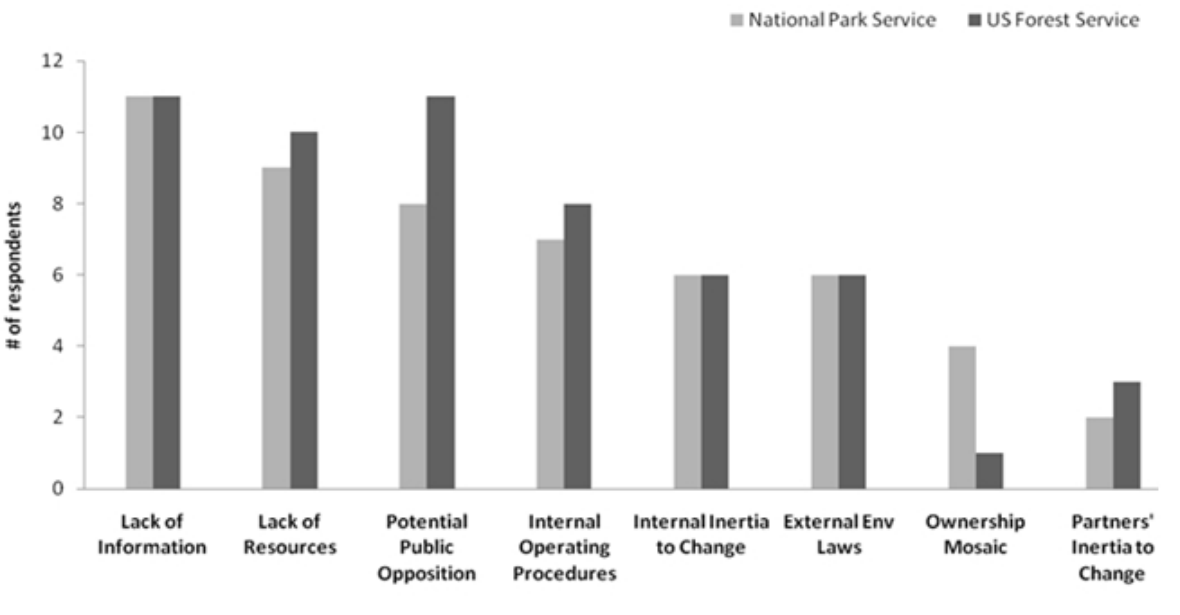
Fig. 3 . Interviewee responses regarding barriers to implementing